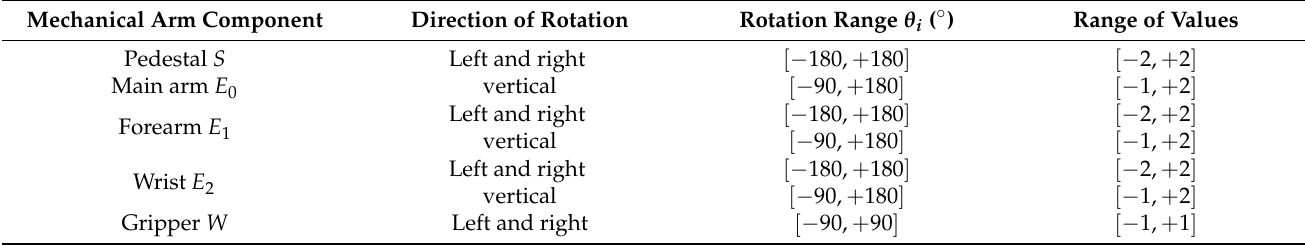
Table 2. The definition of action